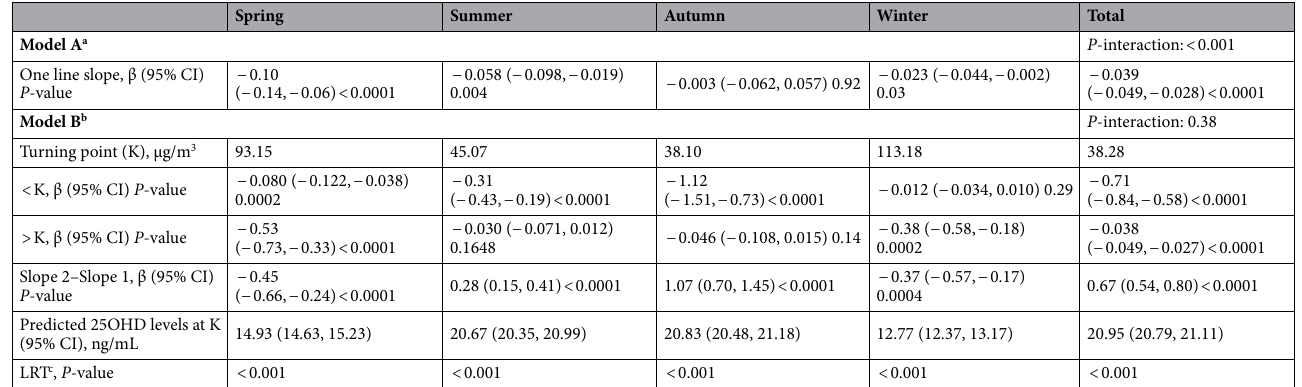
Table 4. Threshold effect analysis examining associations between 60-day moving daily average PM 10 level and maternal serum 25OHD levels during second trimester in subgroups stratified by season of blood collection. Adjusted for year, age, 60-day moving daily average atmospheric pressure, sunshine duration, relative humidity and wind speed. PM 10 particulate matter with an aerodynamic diameter of ≤ 10 μm, 25OHD 25-hydroxy vitamin D, CI confidence interval, LRT logarithmic likelihood ratio test. a Linear analysis, P -value < 0.05 indicates a linear relationship. b Non-linear analysis. c P < 0.05 means Model B is significantly different from Model A, which indicates a non-linear relationship.